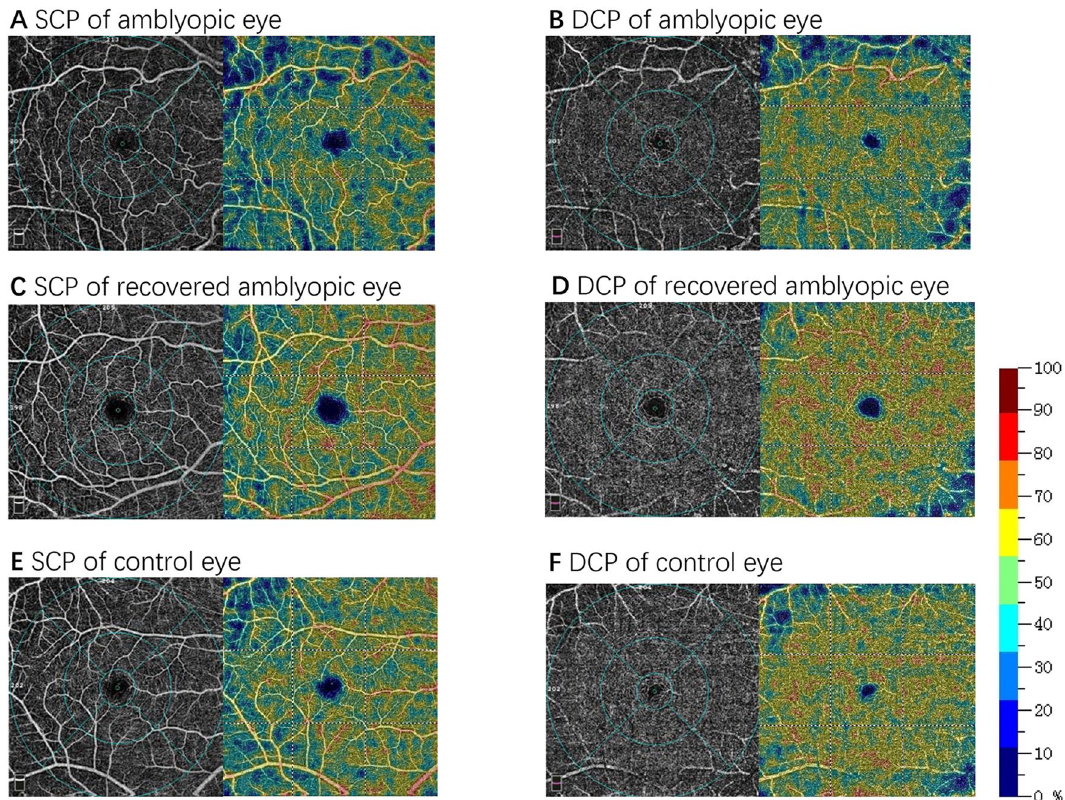
Figure 1. Results from 6 × 6-mm macular scans of vessel density in the superficial retinal capillary plexus (SCP) and deep retinal capillary plexus (DCP) of an amblyopic child ( A and B ), a recovered amblyopic child ( C and D ) and a control child ( E and F ). In the perfusion density maps, a decrease in vessel density is indicated by colder (bluer)